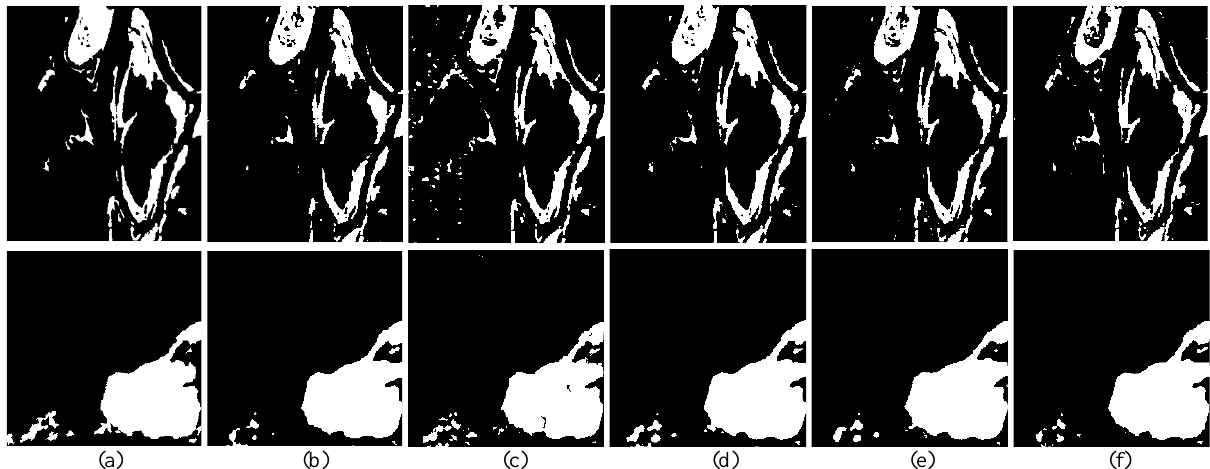
Figure 5. Visualized results for different change detection networks on the Ottawa dataset (first row) and Sulzberger dataset (second row). (a) Ground truth. (b) FC-EF. (c) FC-EF-DI. (d) FC-Siam-conc. (e) FC-Siam-diff. (f) FC-Siam-conc&diff.